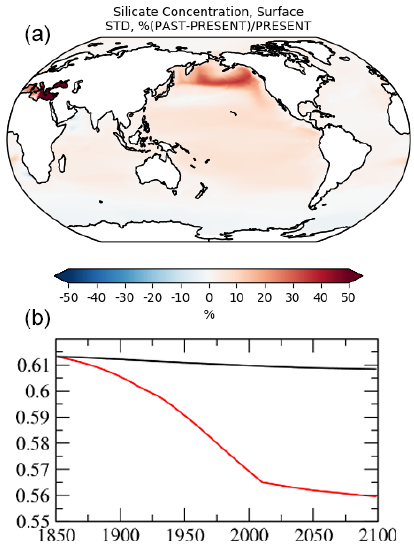
Figure 7. (a) PAST to PRESENT relative differences (%) of sili- cate surface oceanic concentrations as calculated by the model for the STD simulation; (b) seawater concentration ratio of nanophy- toplankton to diatoms in the upper 20m, averaged over the NW Pacific (east of 200 ◦ E and north of 40 ◦ N). The red line indicates primary production rates for the STD simulation and the black line for the CTRL simulation,